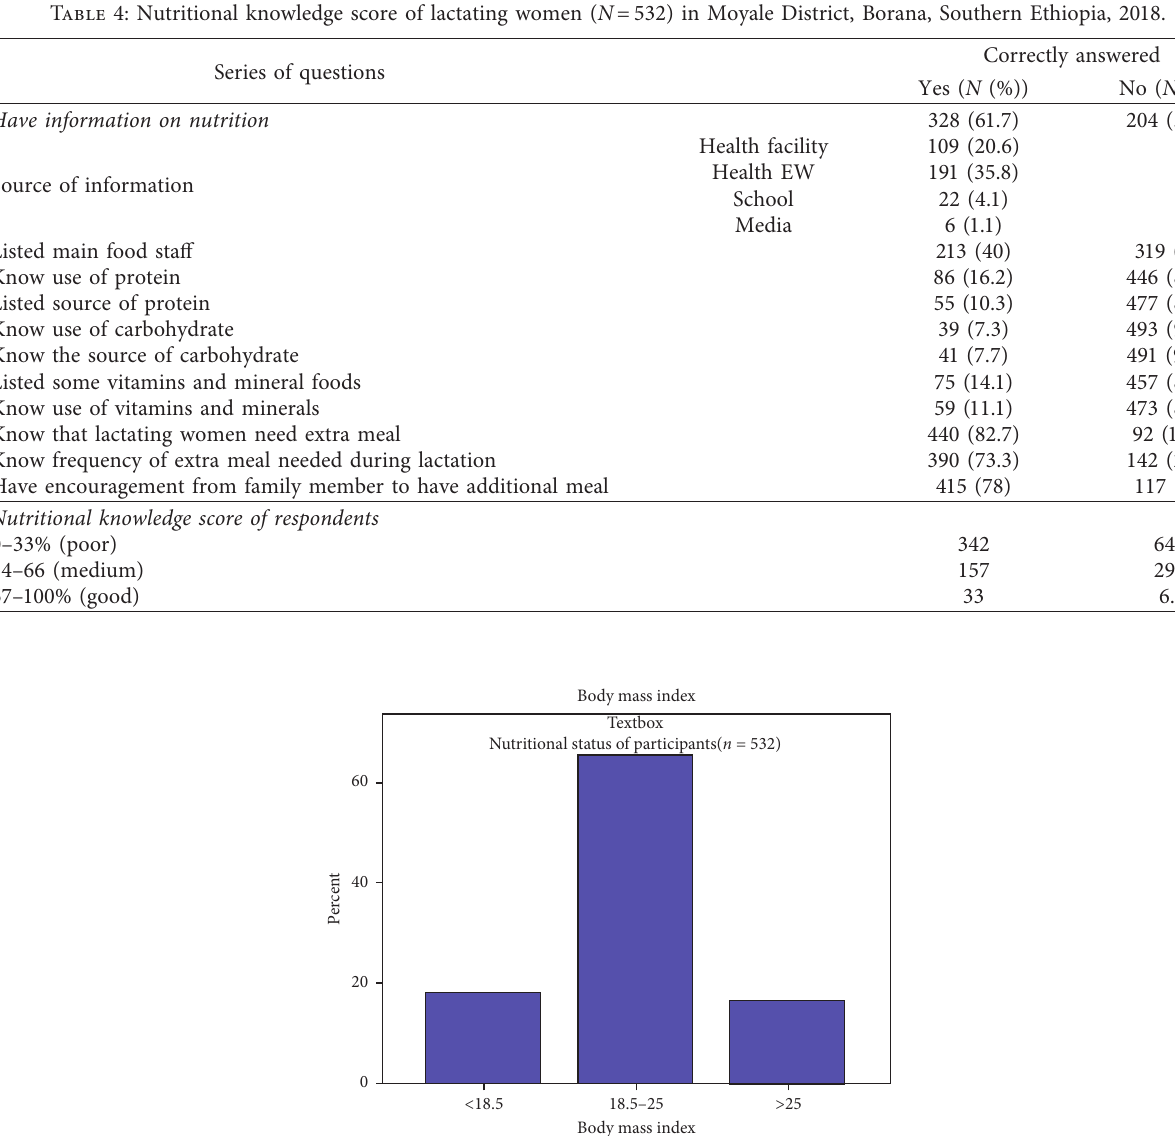
Figure 2: Nutritional status of lactating women ( N � 532) using BMI in Moyale District, Borana, Southern Ethiopia,